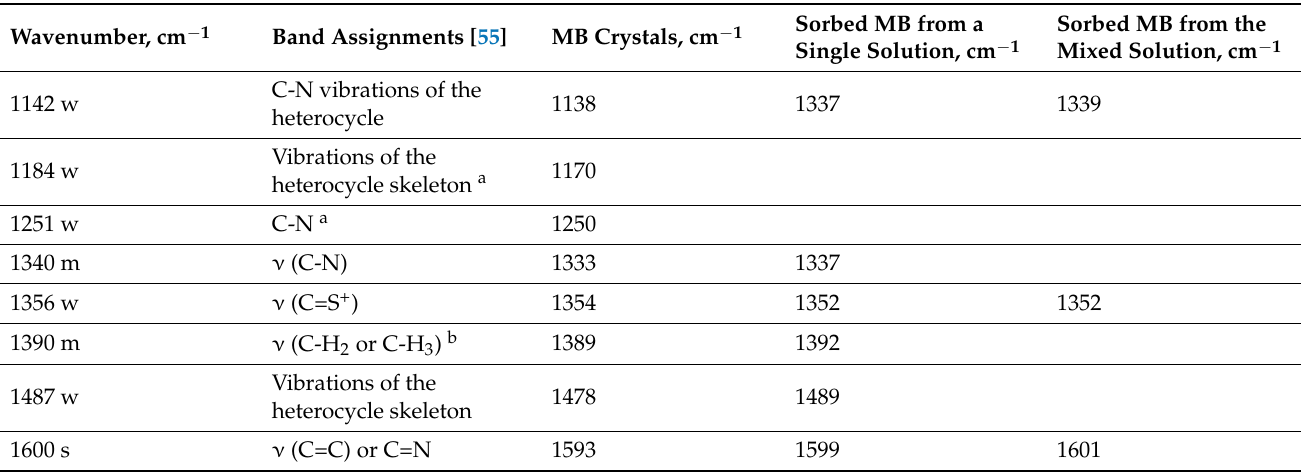
Table 4. Band assignment for MB crystal and MB after sorption on the